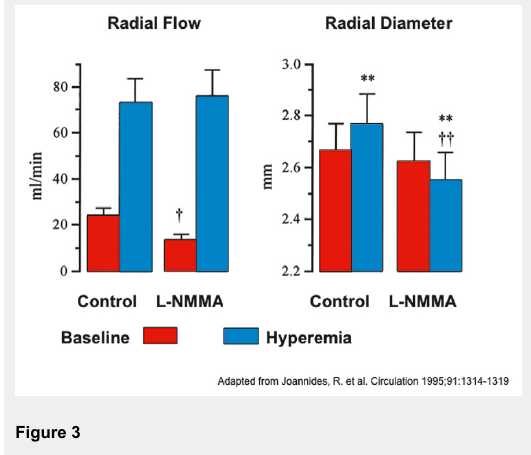
NO in flow-mediated vasodilatation. Radial artery flow (mL/min) and radial artery diameter (mm) measured at baseline and during reactive hyperaemia before and after infusion of NG-monomethyl-L-arginine (L-NMMA). **P <.01 vs Base; P <.05 and P <.01 vs corresponding control value. Modified from Johannides et al. [20].